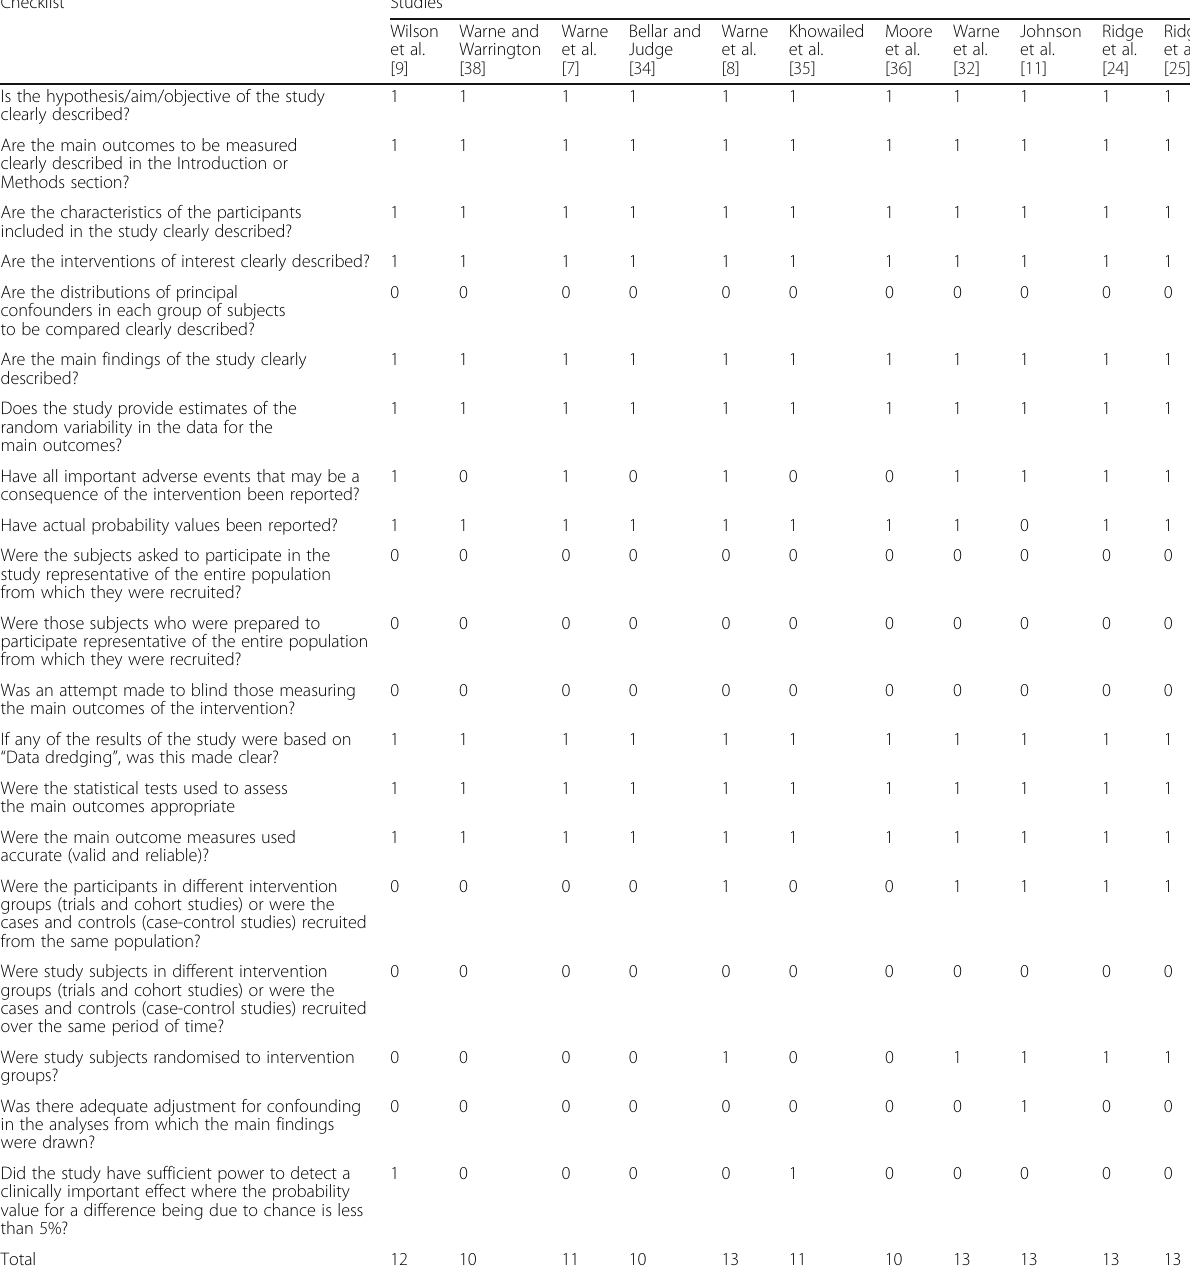
Table 2 Modified Downs and Black ’ s checklist results. The scale was composed of 20 items related to information reporting (items 1 to 9), external validity (items 10 and 11), internal validity (items 12 to 15), and selection bias (items 16 to 20). Each item was scored 0 to represent a high risk of bias or 1 to represent a low risk of bias. Studies that scored a total of 0 to 6 were classified as “ high risk of bias ” , from 7 to 13 as “ moderate risk of bias ” , and from 14 to 20 as “ low risk of bias